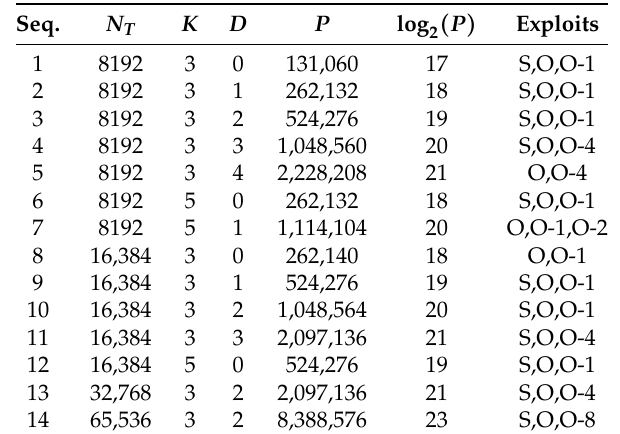
Table 3. Perfect periodic sequences (PPSs) for room impulse response (RIR) estimation ( N T RIR length, from 1 to